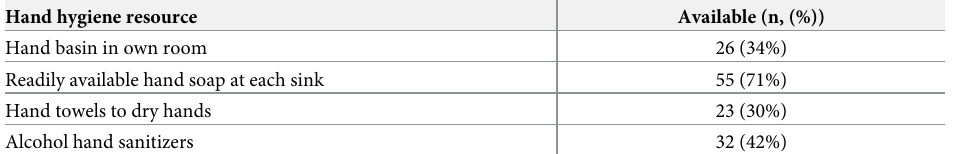
Table 3. Mothers’ perception of the availability of hand hygiene resources at CCs (a total of 77 responses from 59 mothers at 26 CCs). Hand hygiene resource